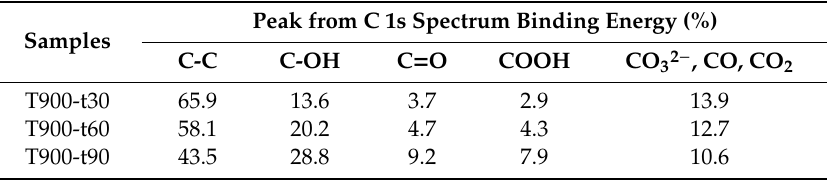
Table 2. Results of the fits of the C 1s region.